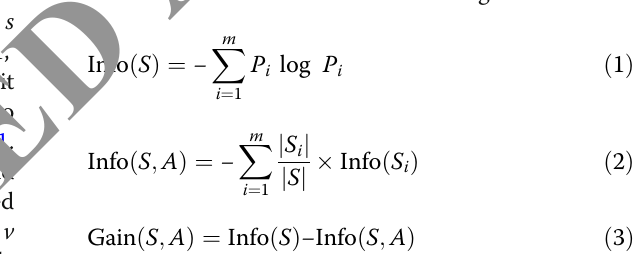
Figure 2 is the process of the decision tree generation process.